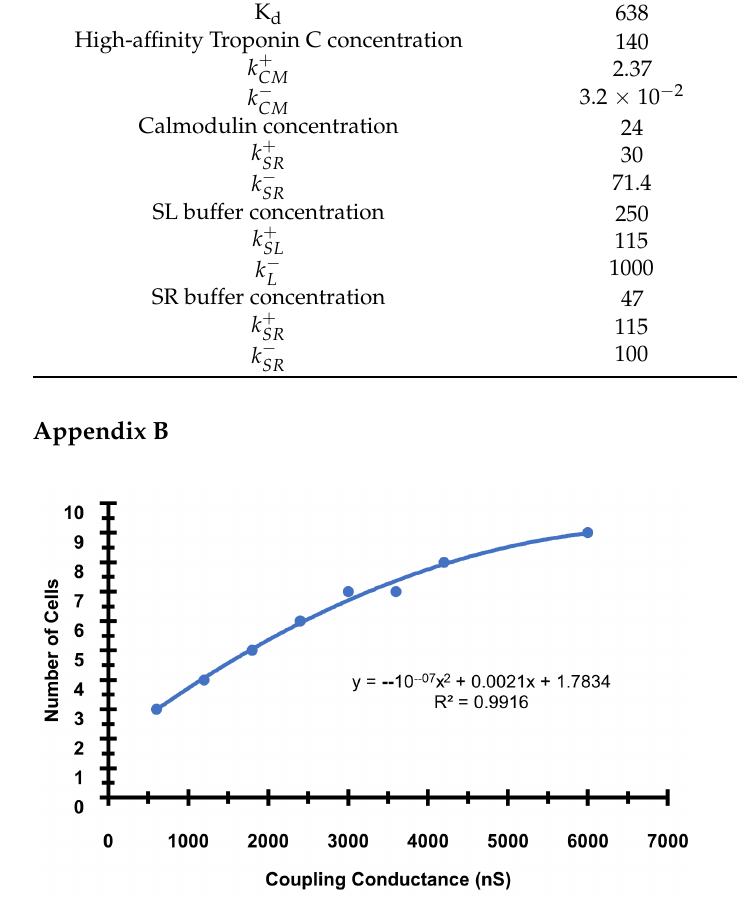
Figure A1. The number of cells needed to initiate a propagating AP increases as the gap junction conductance increases. The base gap junction conductance used in the simulations is 2400 ns. The formula and R 2 for trendline is included in the inset.